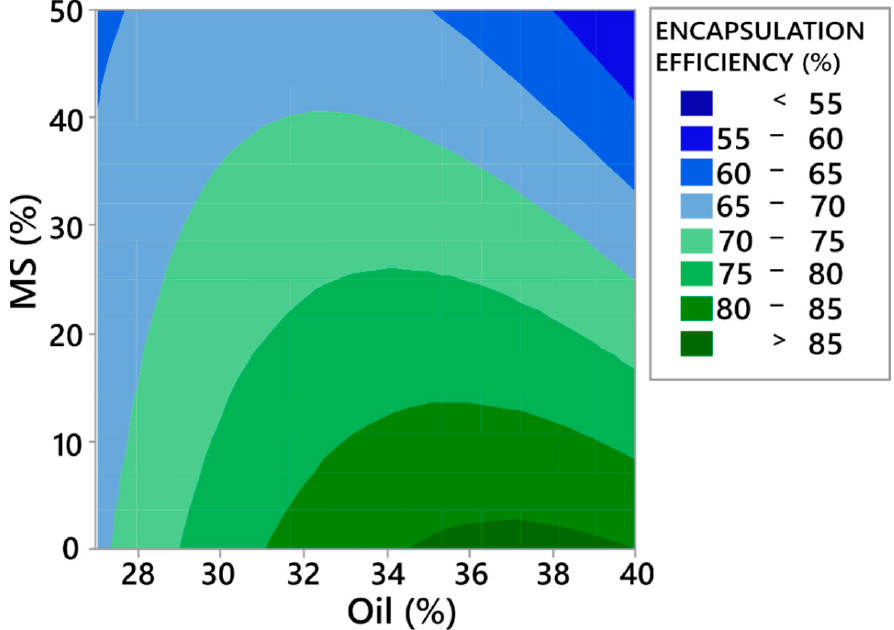
Figure 4. Contour plot showing the effect of oil and MS percentage on encapsulation efficiency.